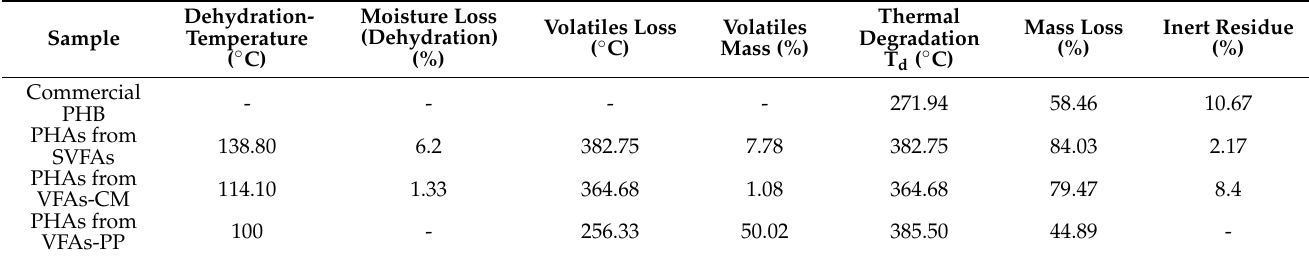
Table 5. Thermogravimetric analysis (TGA) data of produced PHAs in this study.